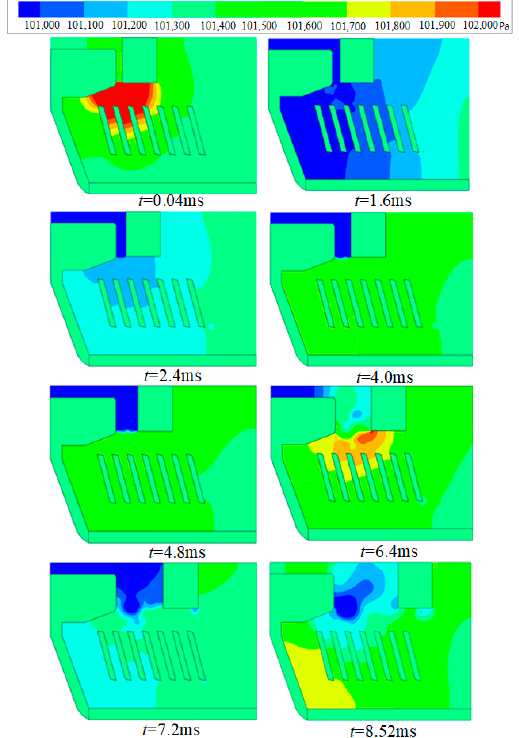
Figure 4. Pressure distribution.